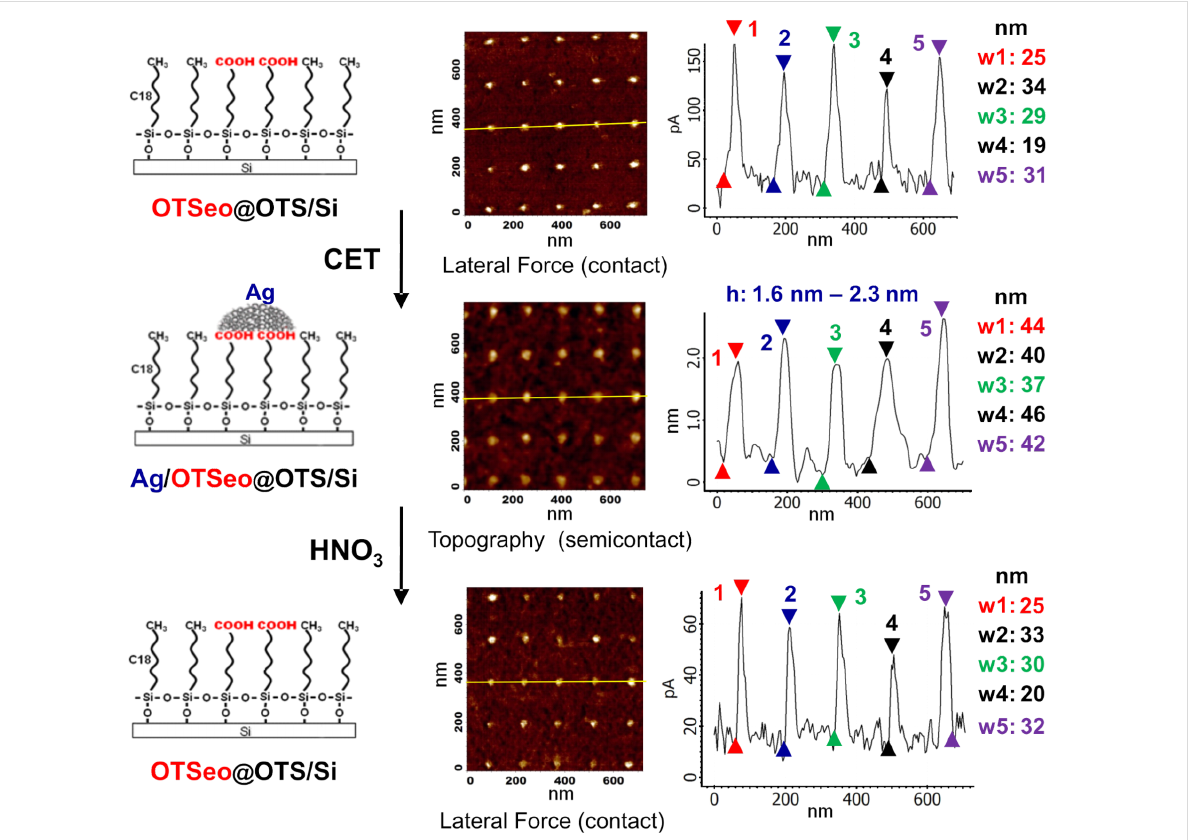
Figure 2: SFM images (and distance–height profiles along the marked lines) acquired after each step during the fabrication of an array of silver/ monolayer nanodots by the contact electrochemical process depicted in Figure 1, as well as after removal of the metal by dissolution in nitric acid (see Experimental section): (Top row) the initial target array of monolayer-template nanodots (OTSeo@OTS/Si); (middle row) array of metal/monolayer template nanodots (Ag/OTSeo@OTS/Si); (bottom row) recovered array of OTSeo@OTS/Si monolayer-template nanodots, after removal of the deposited metal. Contact-mode topographic images of the metal-free dots (top and bottom rows) show a similar scan-dependent weak contrast rela- tive to the OTS background, indicative of the structural integrity of the OTSeo monolayer template (see [30] and Supporting Information File 1, Figures S2 and